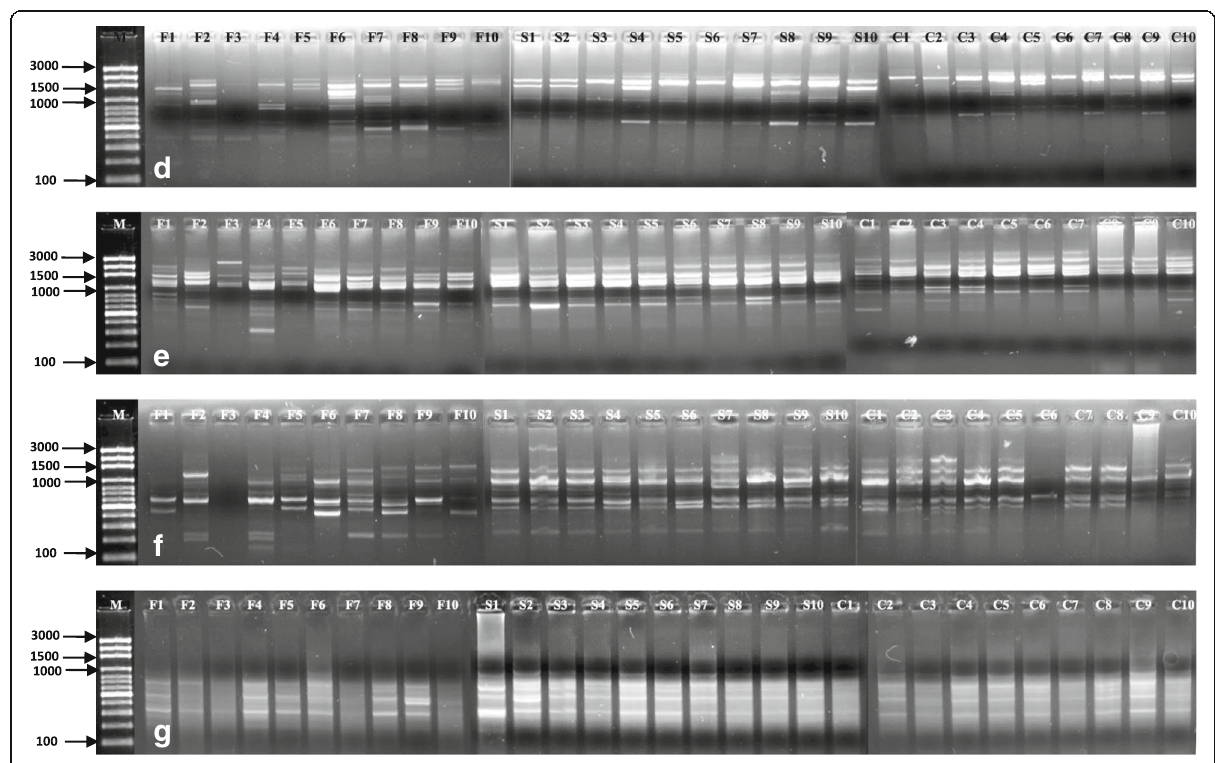
Fig. 5 RAPD patterns of three growth forms of Dendrocalamus strictus generated by primer OPN 11 ( d ), OPN 13 ( e ), OPN 20 ( f ) and OPX 12 ( g ). M-Molecular weight ladder (100 bp); F1 – F10 = FRI campus, S1 – S10 = Shivpuri range and C1 – C10 = Chiriapur